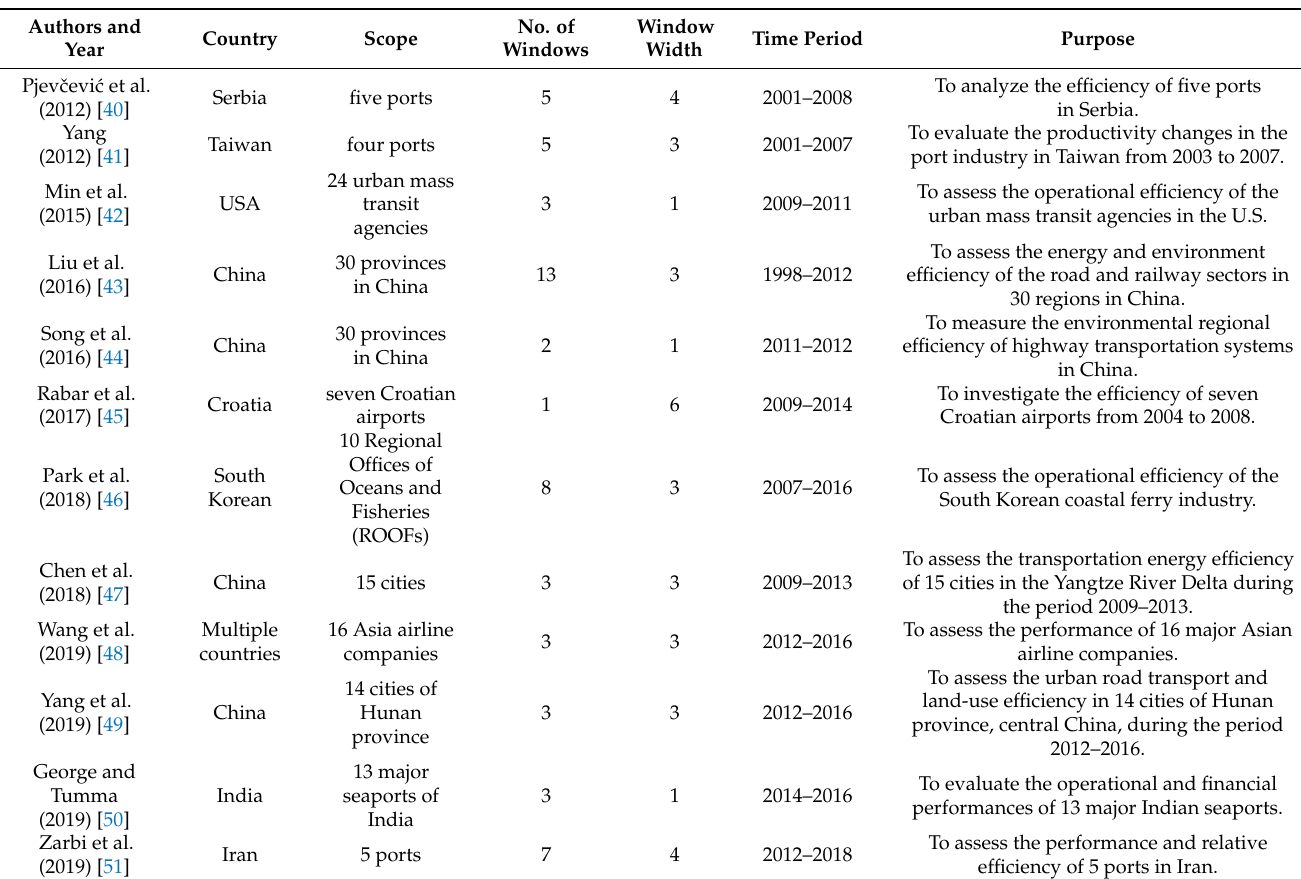
Table 4. Articles classified under the transportation category.